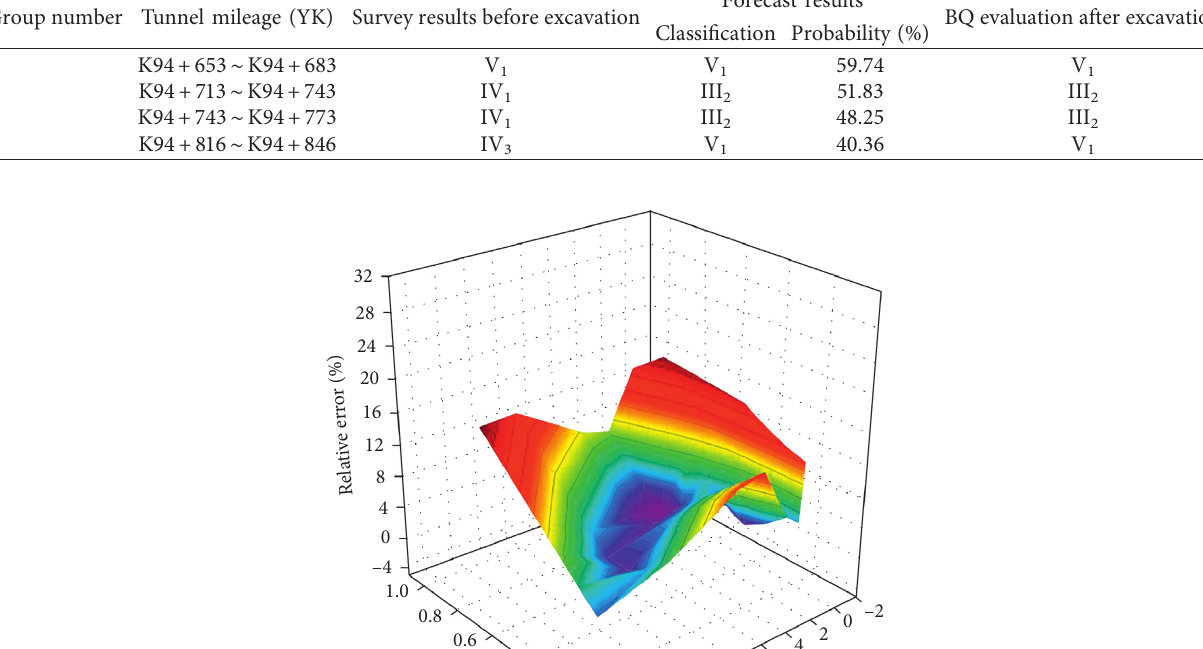
Table 6: Classification results verification of Suqiao tunnel. Forecast results Group number Tunnel mileage (YK) Survey results before excavation